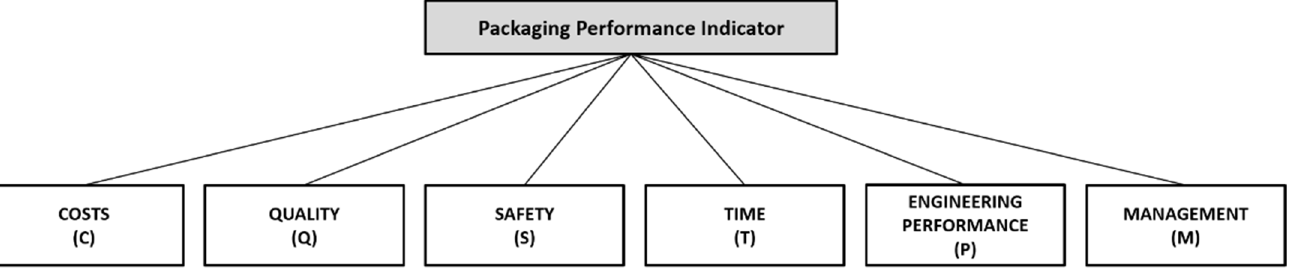
Figure 3. Model hierarchy tree.